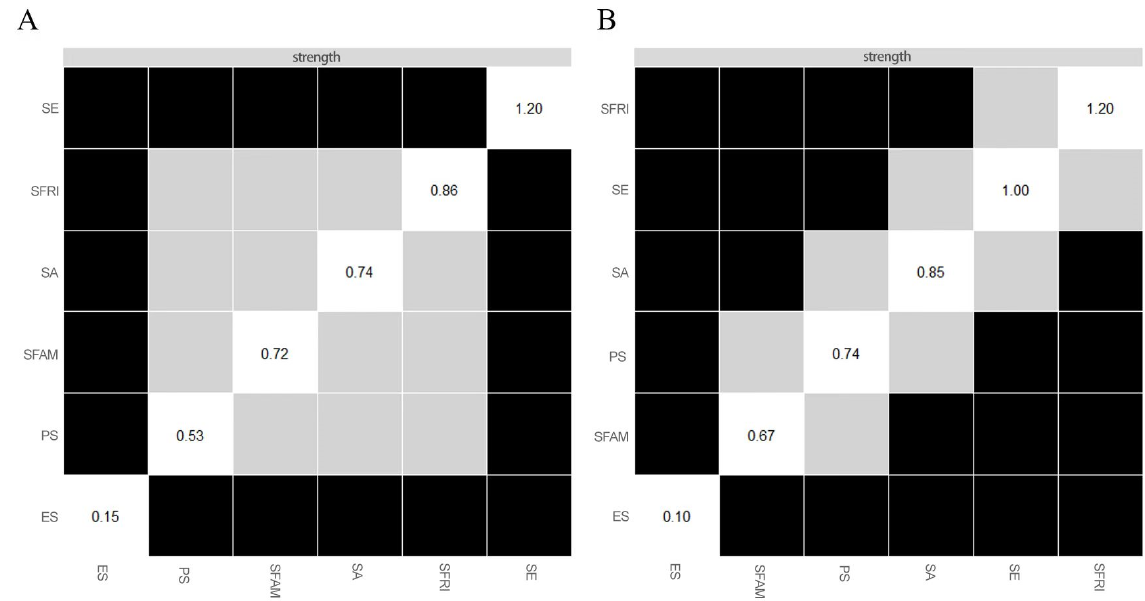
Figure 5. Estimation of node strength difference by bootstrapped difference test. Note, bootstrapped difference tests between node strength of factors. Grey boxes indicate nodes that do not significantly differ from one another. Black boxes represent nodes that differ significantly from one another (α = 0.05). White boxes show the values of node strength. ( A ), wave 1. ( B ), wave 2.